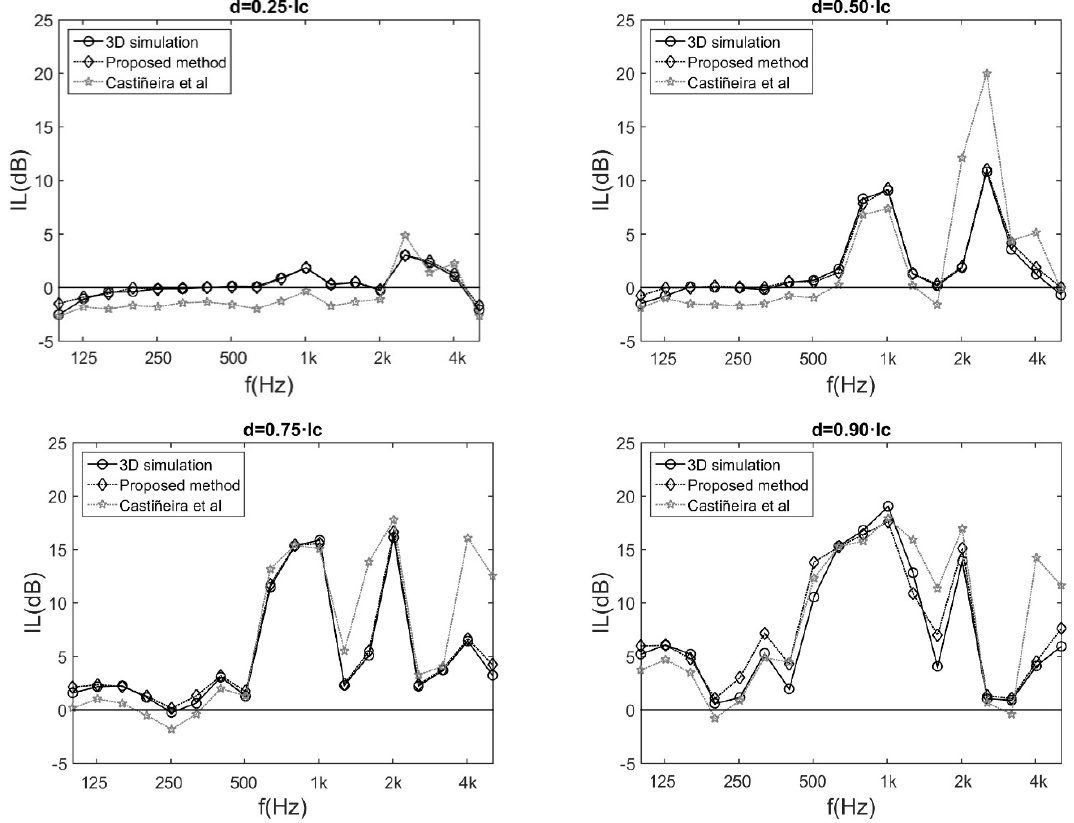
Figure 9. Comparison of the values of IL provided by the proposed method (Equation (5)) and the “overlapping method” proposed by Castiñeira et al. [23,24]. Different relations between the diameter of the scatterers and the lattice constant are illustrated. Top left, 25%; top right, 50%; bottom left, 75%; and bottom right, 90%. (Lines with circular markers: 3D numerical simulation; Lines with rhombus markers: proposed model (Equation (5)); Lines with star markers: “overlapping method” by Castiñeira et al. [23,24]).